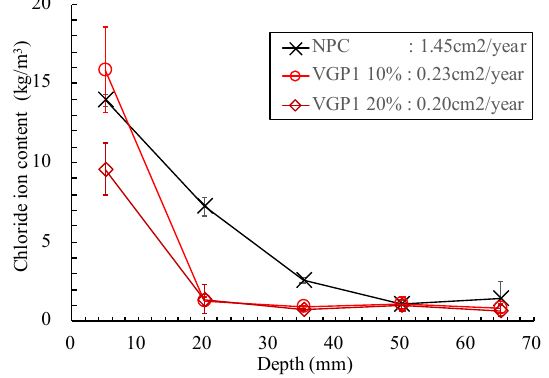
Figure 19. Results of phenolphthalein tests at accelerated age of 26 weeks.